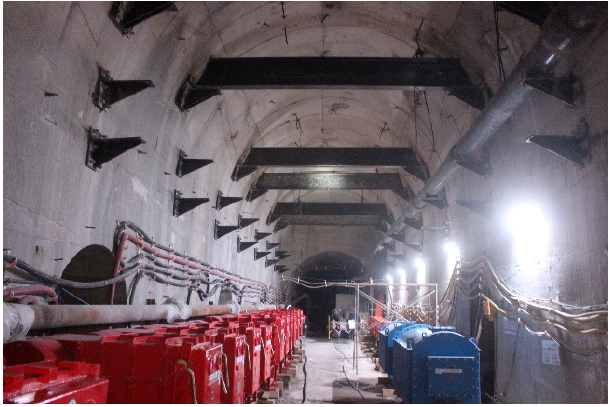
Figure 12. Field effect of pump house after reinforcement.